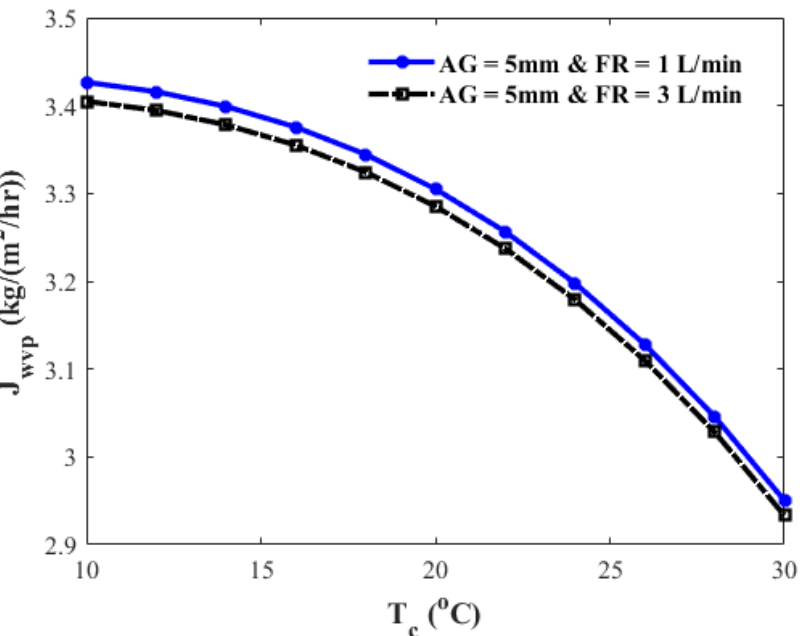
Figure 13. Effect of the cold feed (FR = 1 and 3 L/min) on the J wvp at different cold feed temperatures (T c ) (air gap thickness (AG) of 5 mm).